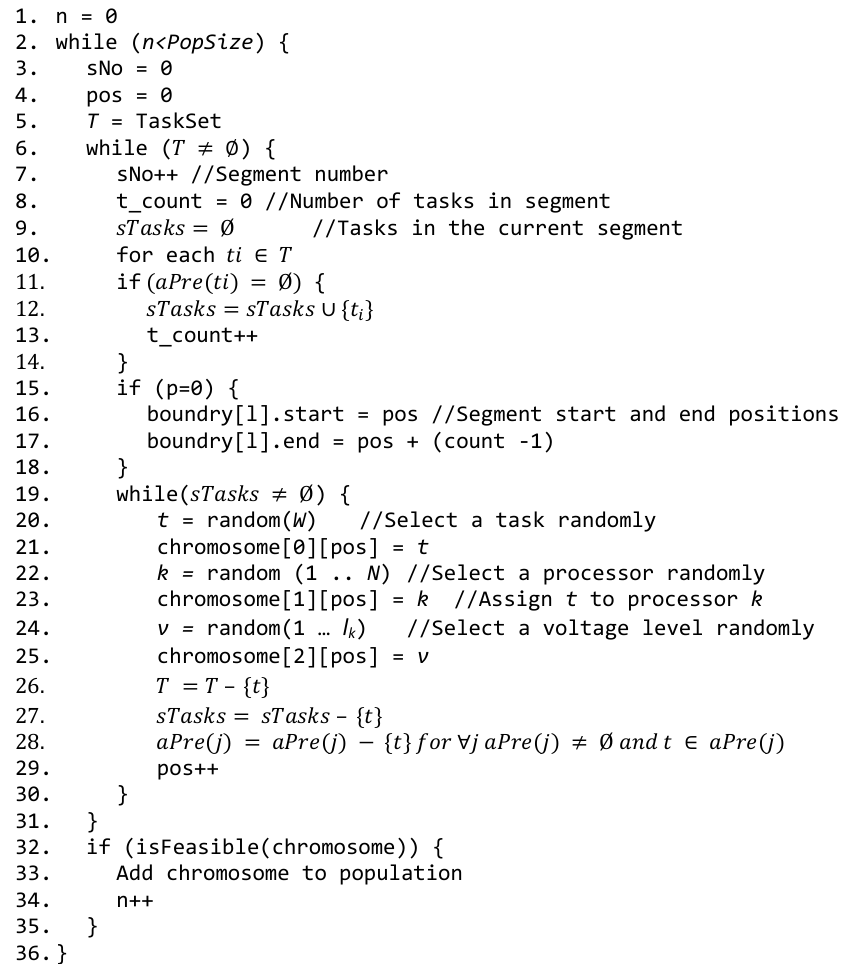
Figure 5. The initial solution generation algorithm.